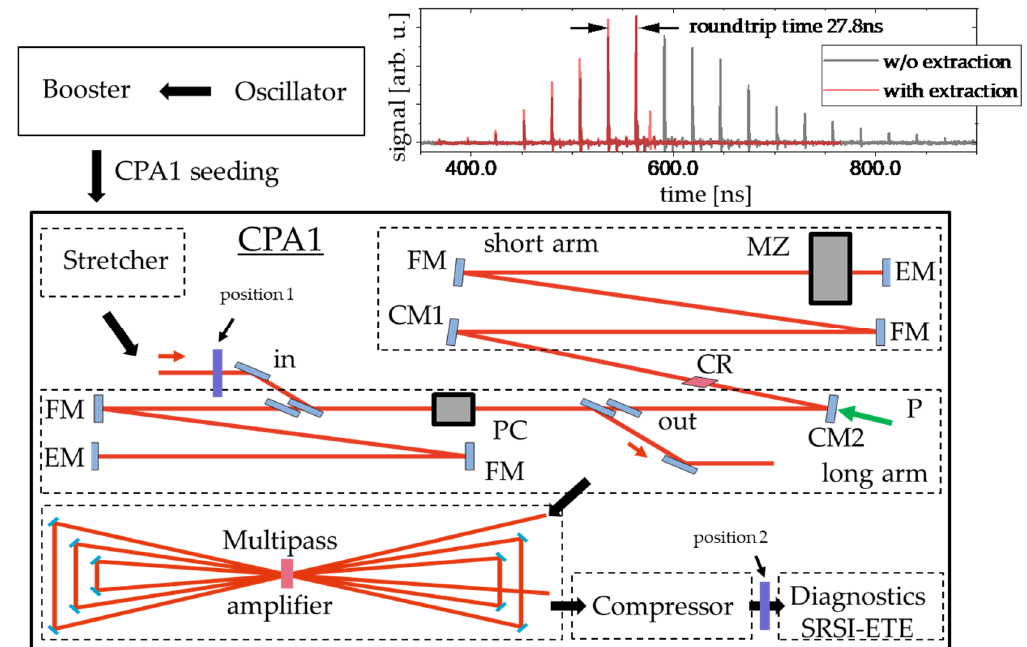
Figure 1. Experimental setup around the CPA1 stage of the Draco high-power laser system. An oscillator is followed by a pre-amplifier stage called booster. After that pulses with 10 Hz repetition rate are sent into a Öffner-type stretcher and a Dazzler. The stretched pulses are then seeded into the regenerative amplifier having a folded (FM folding mirror) geometry and a round trip time between the end mirrors (EM) of 27.8 ns (upper inset: measurement of roundtrip energy with a photodiode behind EM). The injection and extraction is performed with a double switching Pockels cell (PC) and a set of thin film polarizers in the long arm. The active material (CR) is placed between the curved mirrors (CM1 & CM2). The pump light at 532 nm is focused onto the crystal through CM2. For controlling the spectral bandwidth, a Mazzler device (MZ) is applied in the short arm. The regenerative amplifier is followed by a 6-pass amplifier and subsequent a grating compressor, delivering pulses of 30 fs FWHM temporal pulse length and 10−20 mJ energy. Behind the compressor the SRSI-ETE device is applied for single-shot measurements using a fraction of the compressed laser pulses. The glass plate generating post-pulses can be placed at position 2 before the SRSI-ETE device as reference and at position 1 for measuring the coupling in the laser chain.